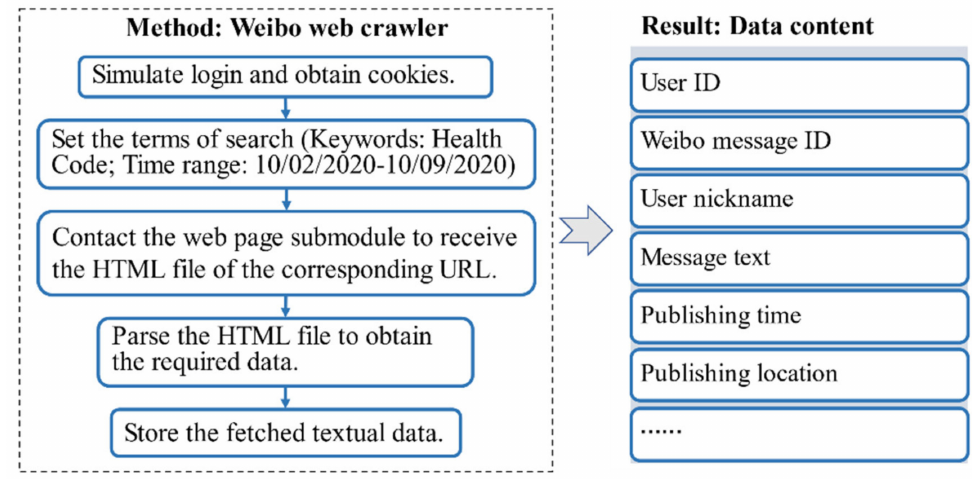
Figure 3. Weibo data collection